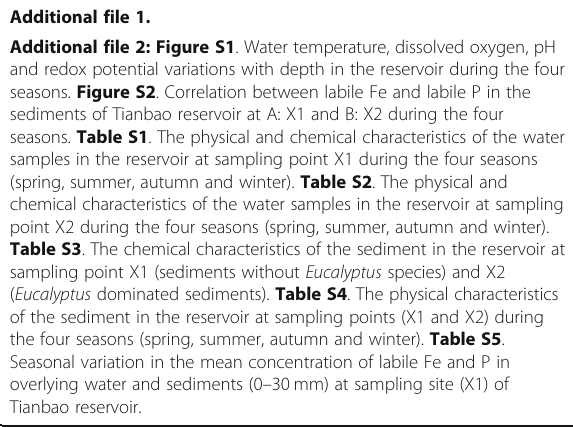
Abbreviations Fe: Iron; P: Phosphorus; SWB: Sediment-water boundary; FeS: Iron sulfide; DO: Dissolved oxygen; DGT: Diffusive gradient in thin films; PO: Planar optode; DIFS: DGT-induced fluxes in soil; YSI: Yellow spring instrument; T: Temperature; EC: Conductivity; OM: Organic matter; ORP: Oxidation- reduction potential; TP: Total phosphorus; TFe: Total iron; Mn: Manganese; S: Sulfide; NH 3 -N: Ammonia nitrate; TN: Total nitrogen; DOC: Dissolved organic carbon; Mn: Manganese; Ni: Nickel; Cu: Copper; Zn: Zinc; As: Arsenic; Cd: Cadmium; Pb: Lead; R: Resupply kinetics; Kd: Distribution equilibrium coefficient; T c : Response time of (de)sorption process; k 1 : Sorption rate constant; k − 1 : Desorption rate